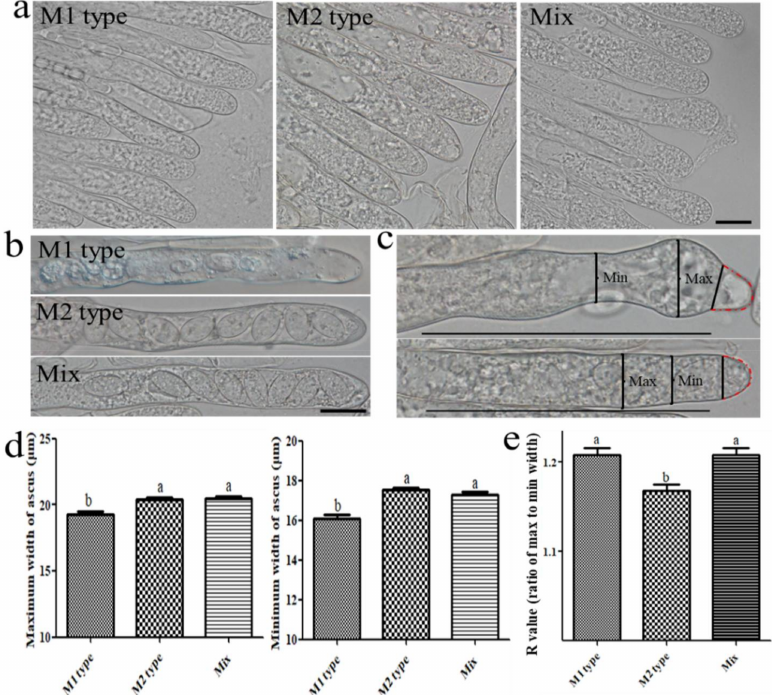
Figure 4. Morphology of the ascus of different mating types. ( a , b ) Morphology of the ascus of different types of fruiting bodies, bar = 20 µ m; ( c ) the malformation degree measurement instructions, bar = 100 µ m; ( d ) maximum and minimum size of the ascus; ( e ) the malformation degree of the ascus of different types. Different letters indicate significant differences (Table S3.6–3.8), one-way ANOVA, p < 0.05.